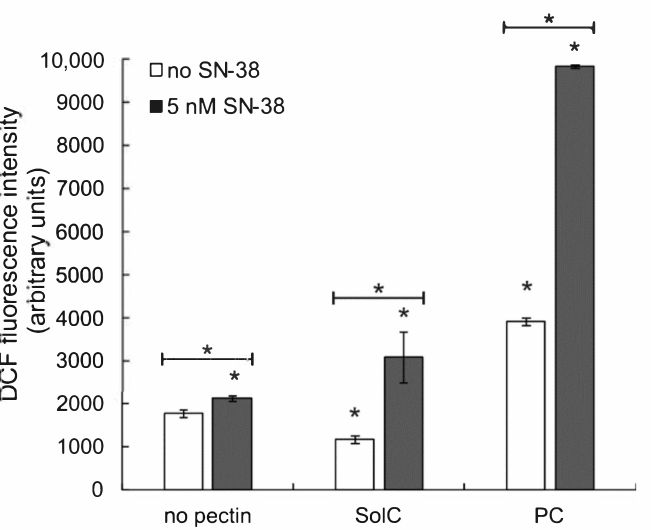
Figure 5. ROS level in HCT 116 cells treated with 0.2 mg/mL pectins and/or 5 nM SN-38 for 48 h. The means of three experiments ± SD are presented (* p < 0.05). Statistical significance was checked between the studied probes and controls (no pectin) as well as between probes containing only pectin and pectin combined with